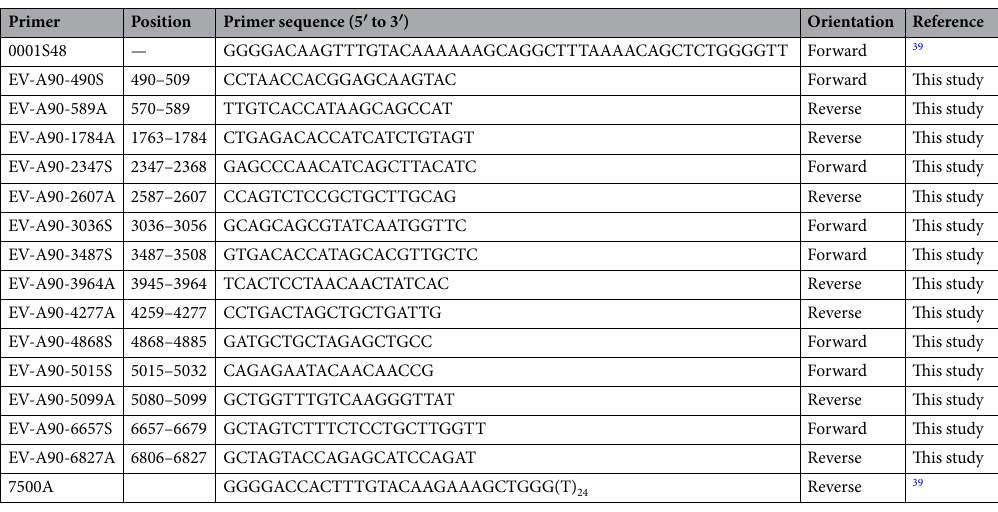
Table 5. PCR and sequencing